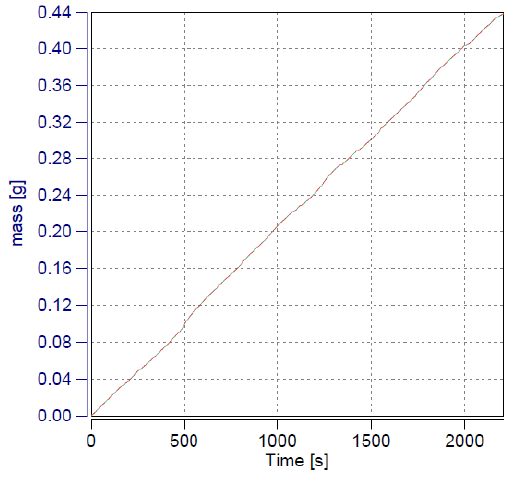
Fig. 8. Particulate mass during the test